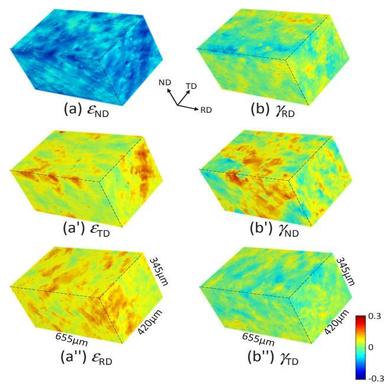
Comparison of strain components distribution with microstructure obtained by SEM/EBSD on a cross-section of the SRCT scanned sample in Al-4.7mass%Mg alloy after 18.6% cold rolling.